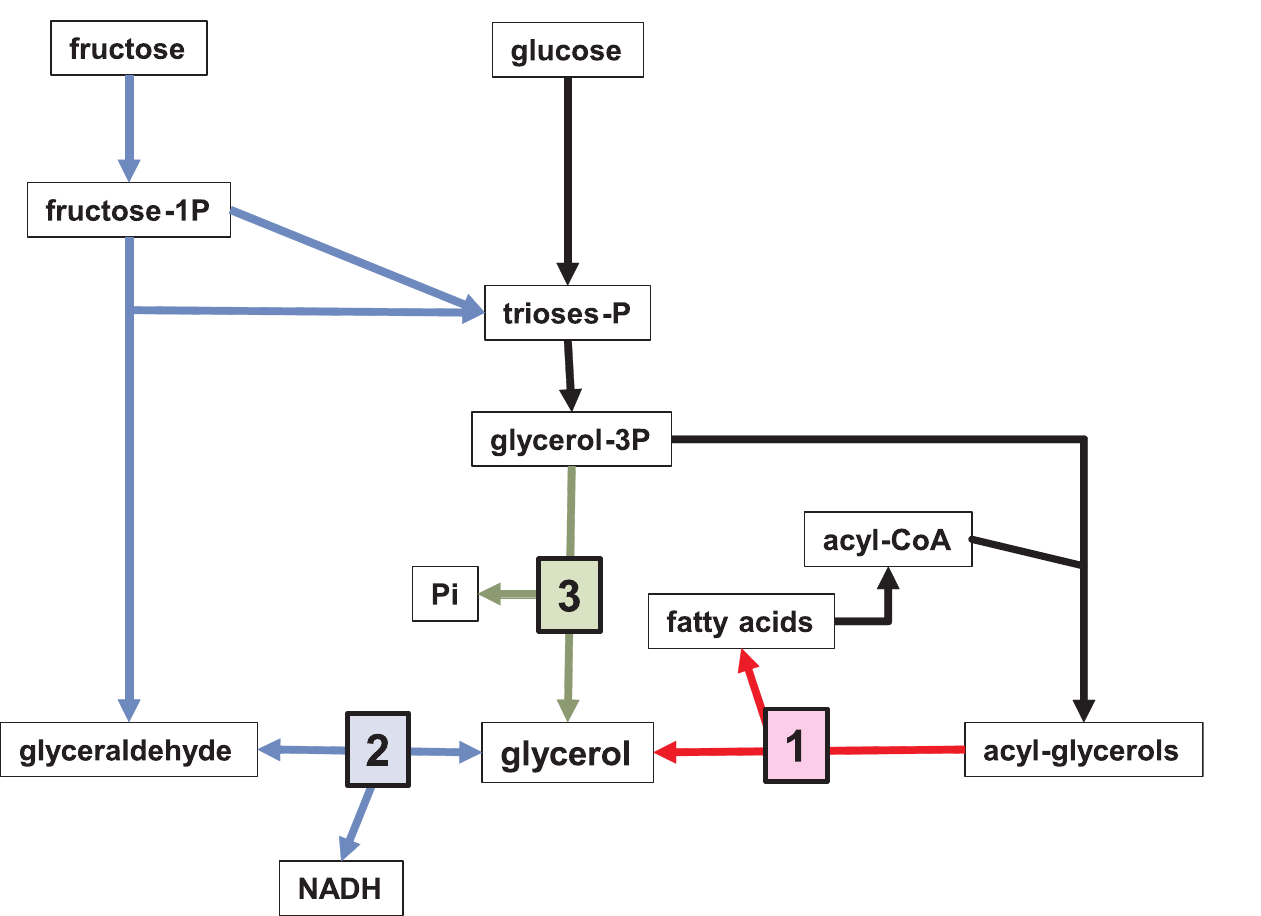
Fig 6. Glycerol-producing pathways in mammalian adipocytes. The numbers indicate the pathways described in the Discussion: 1: lipolysis (red); 2: reduction of fructose-derived glyceraldehyde (exclusive fructose metabolism: blue); 3: postulated glycerol-3-phosphatase pathway